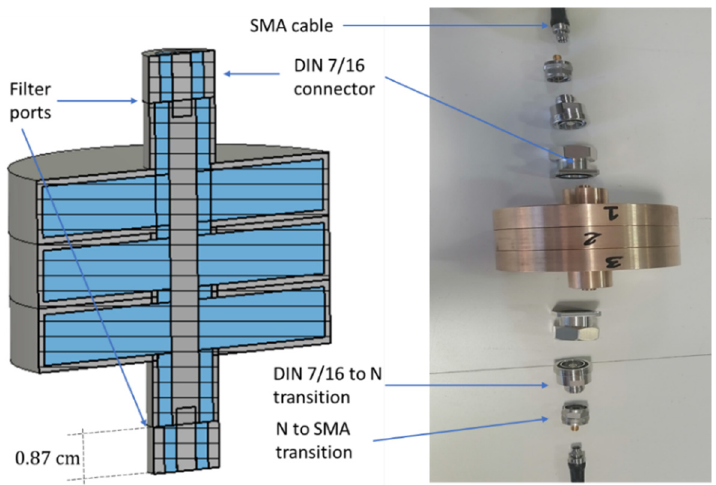
Figure 6. Transition and connectors needed for the connection of the VNA ports to the filter ports.